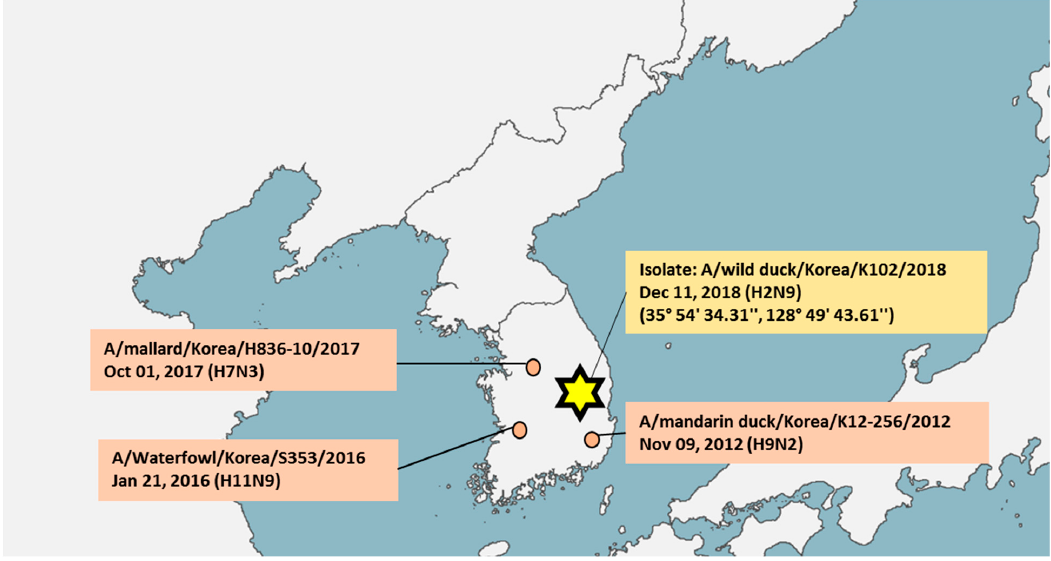
Figure 2. The geographical location of pre-existing subtypes (H7N3, H11N9, and H9N2) and novel isolate (A/wild duck/Korea/K102/2018 (H2N9)) in Korea.